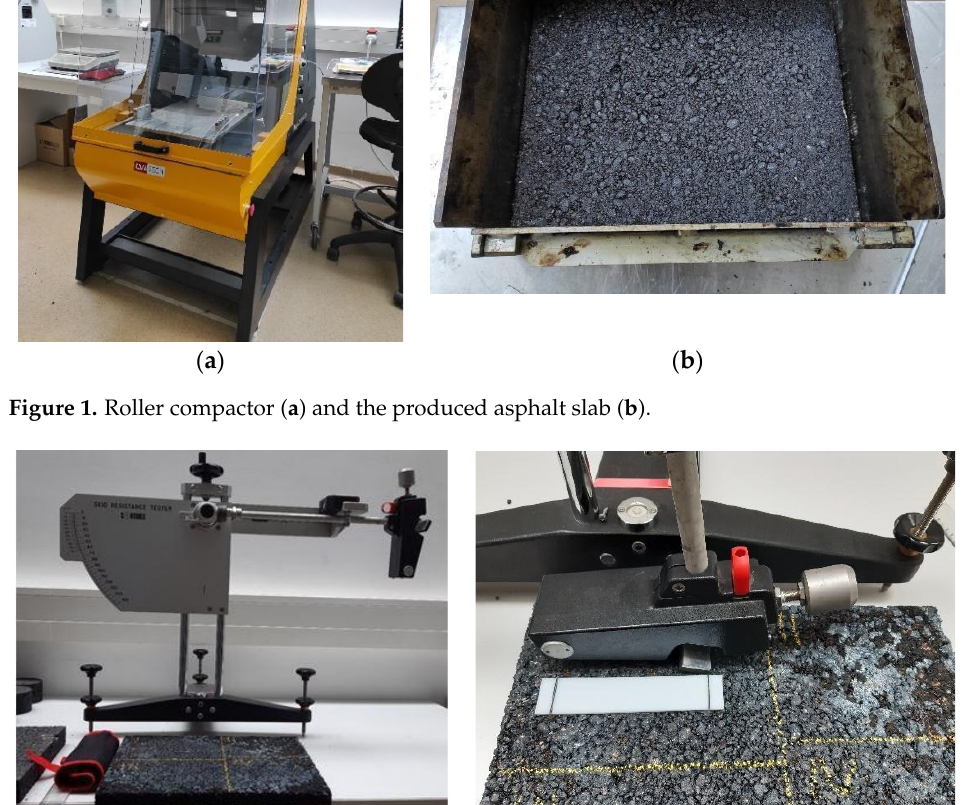
Figure 1. Roller compactor ( a ) and the produced asphalt slab ( b ).